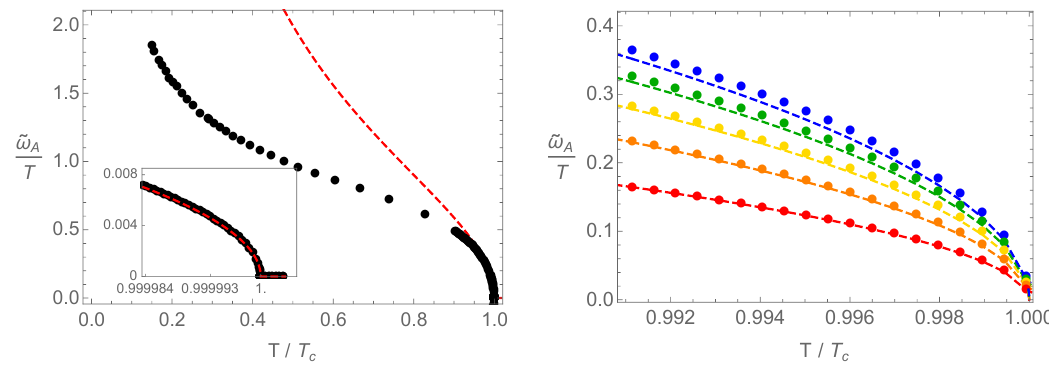
Figure 9 . The gauge field mass ˜ ω A . Dots are numerically obtained by fitting the dispersion relation. Dashed lines represent the analytical expression in eq. (5.13). Left: λ/T = 0 . 1 . Right: λ/T = 0 . 1 − 0 . 5